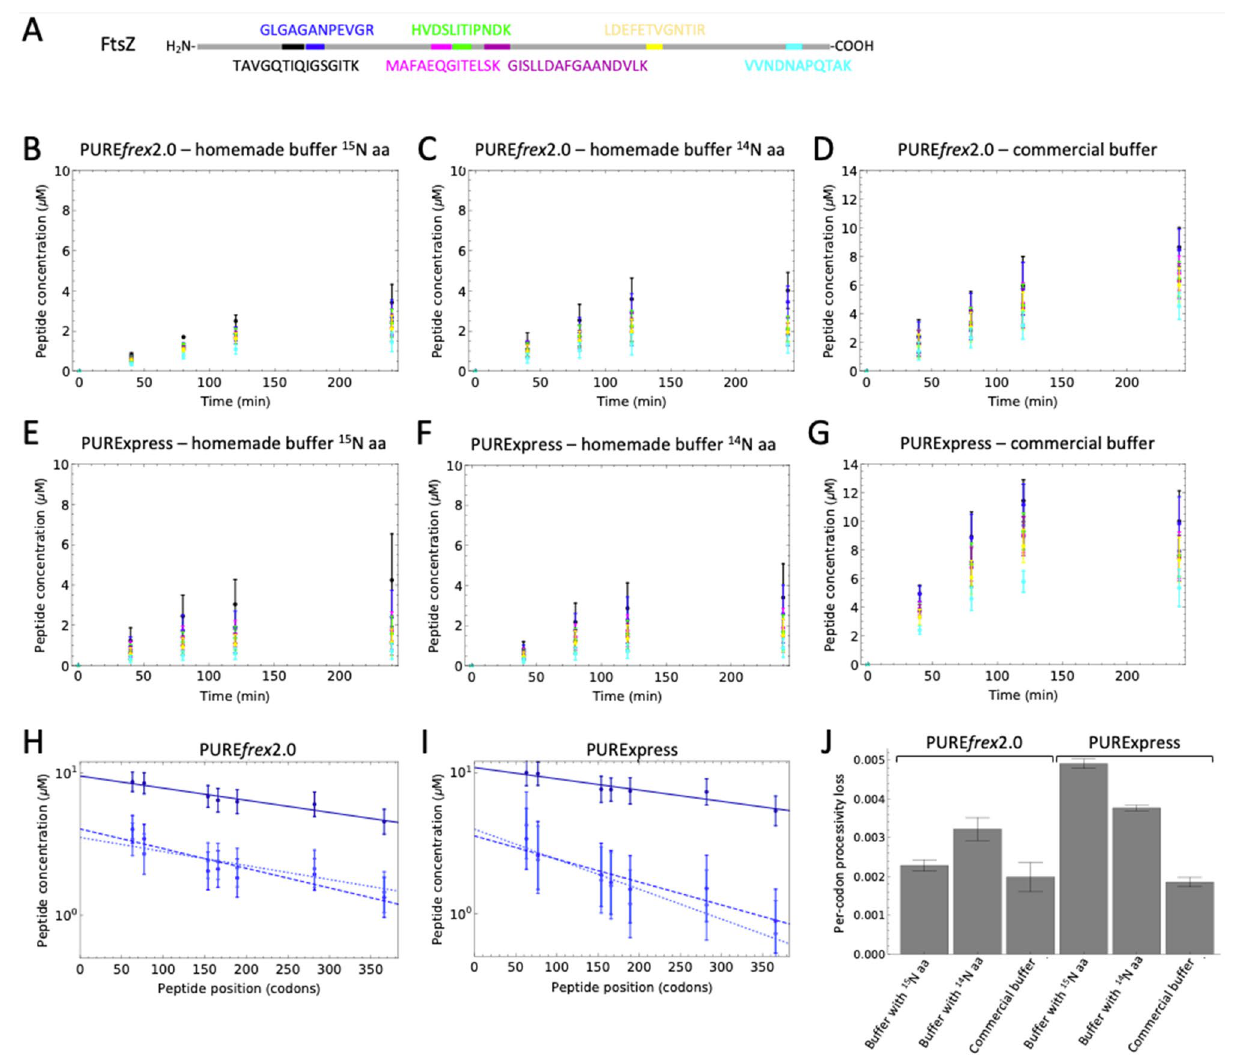
Figure 5. Impaired ribosome processivity occurs also in single-gene expression reactions. ( A ) Schematic of the full-length FtsZ protein displaying the positions of selected peptides. The specific peptides measured are appended. Color coding from N- to C-terminal: black, blue, pink, green, magenta, yellow, cyan. ( B – G ) Time-course of the concentration of the indicated peptides synthesized with PURE frex 2.0 ( B–D ) and with PURExpress ( E – G ). All reactions were performed at 37 °C. Error bars denote ± 1 standard deviation from triplicate experiments. Color coding of the peptides is similar as in ( A ). ( H , I ) End-point (5 h) FtsZ peptide concentration as a function of peptide position for reactions with the commercial buffer (dark blue, solid lines), with the homemade buffer containing unlabeled amino acids (blue, dashed lines) or with 15 N-labeled amino acids (light blue, dotted lines). Straight lines are exponential regression fits. ( J ) Average per-codon processivity loss derived from the slope computed in ( H , I ). Error bars are weighted fit